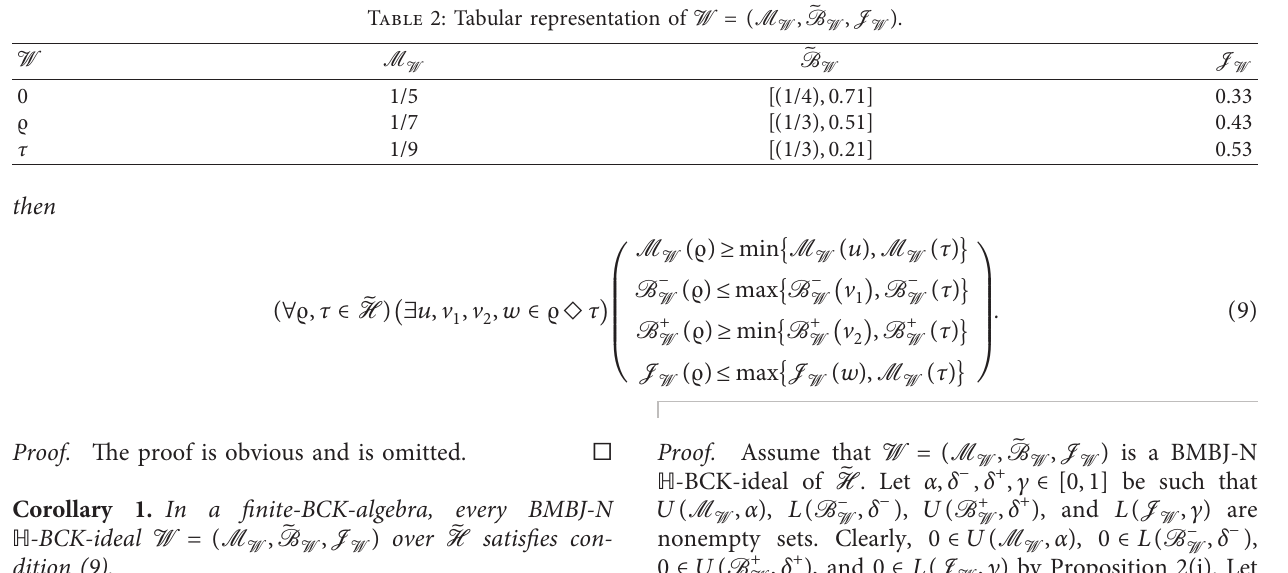
Table 2: Tabular representation of W � ( M